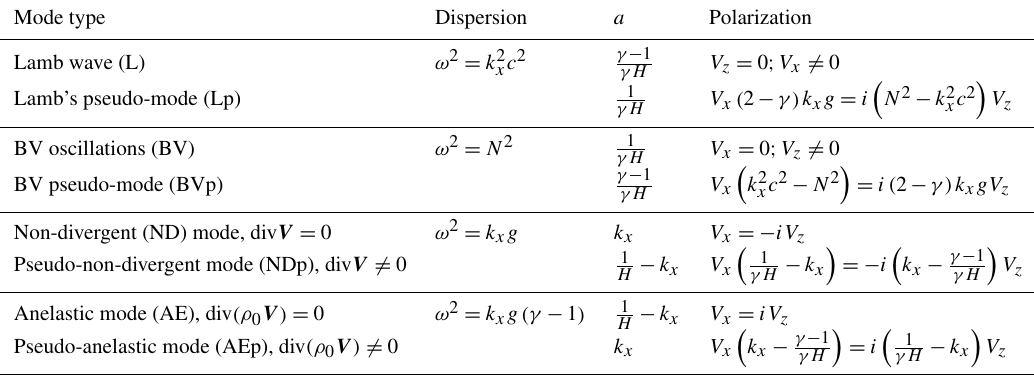
Table 1. Properties of different evanescent acoustic-gravity modes.